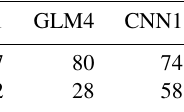
Table A1. Computation times (in minutes) required for the calcula- tion (training and prediction of the test period) for three downscal- ing methods used in this study: GLM1, GLM4 and CNN1 (the rest of the deep configurations yield similar computing